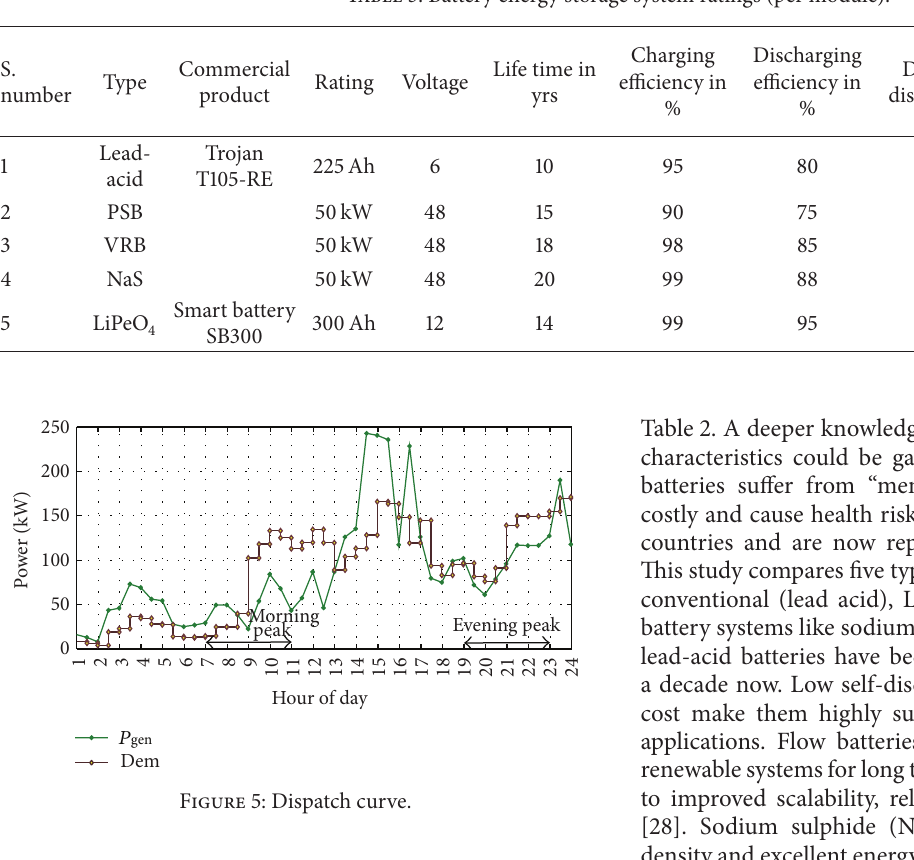
Table 3: Battery energy storage system ratings (per module).